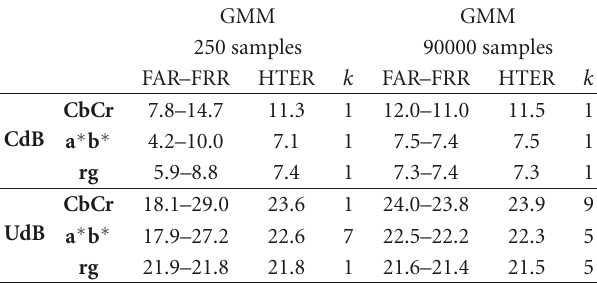
Table 2: HTER values for GMM at EER working point with di ff erent number of skin training samples.